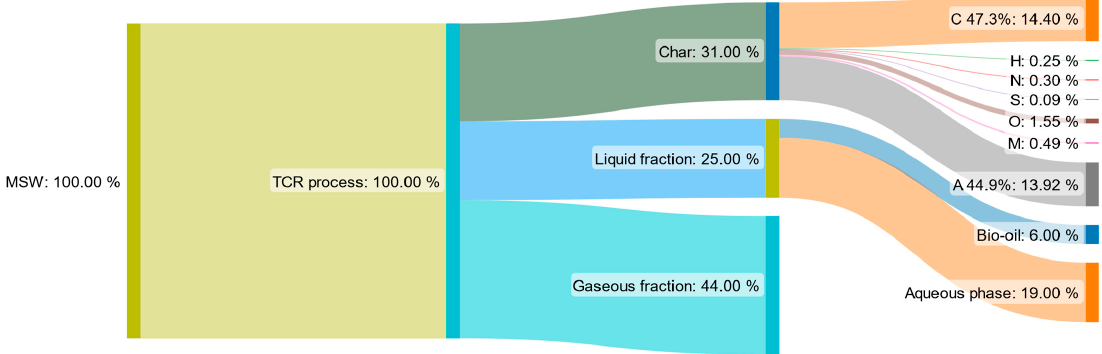
Figure 6. Sankey diagram for MSW as a feedstock in the TCR process (based on data from [3]).